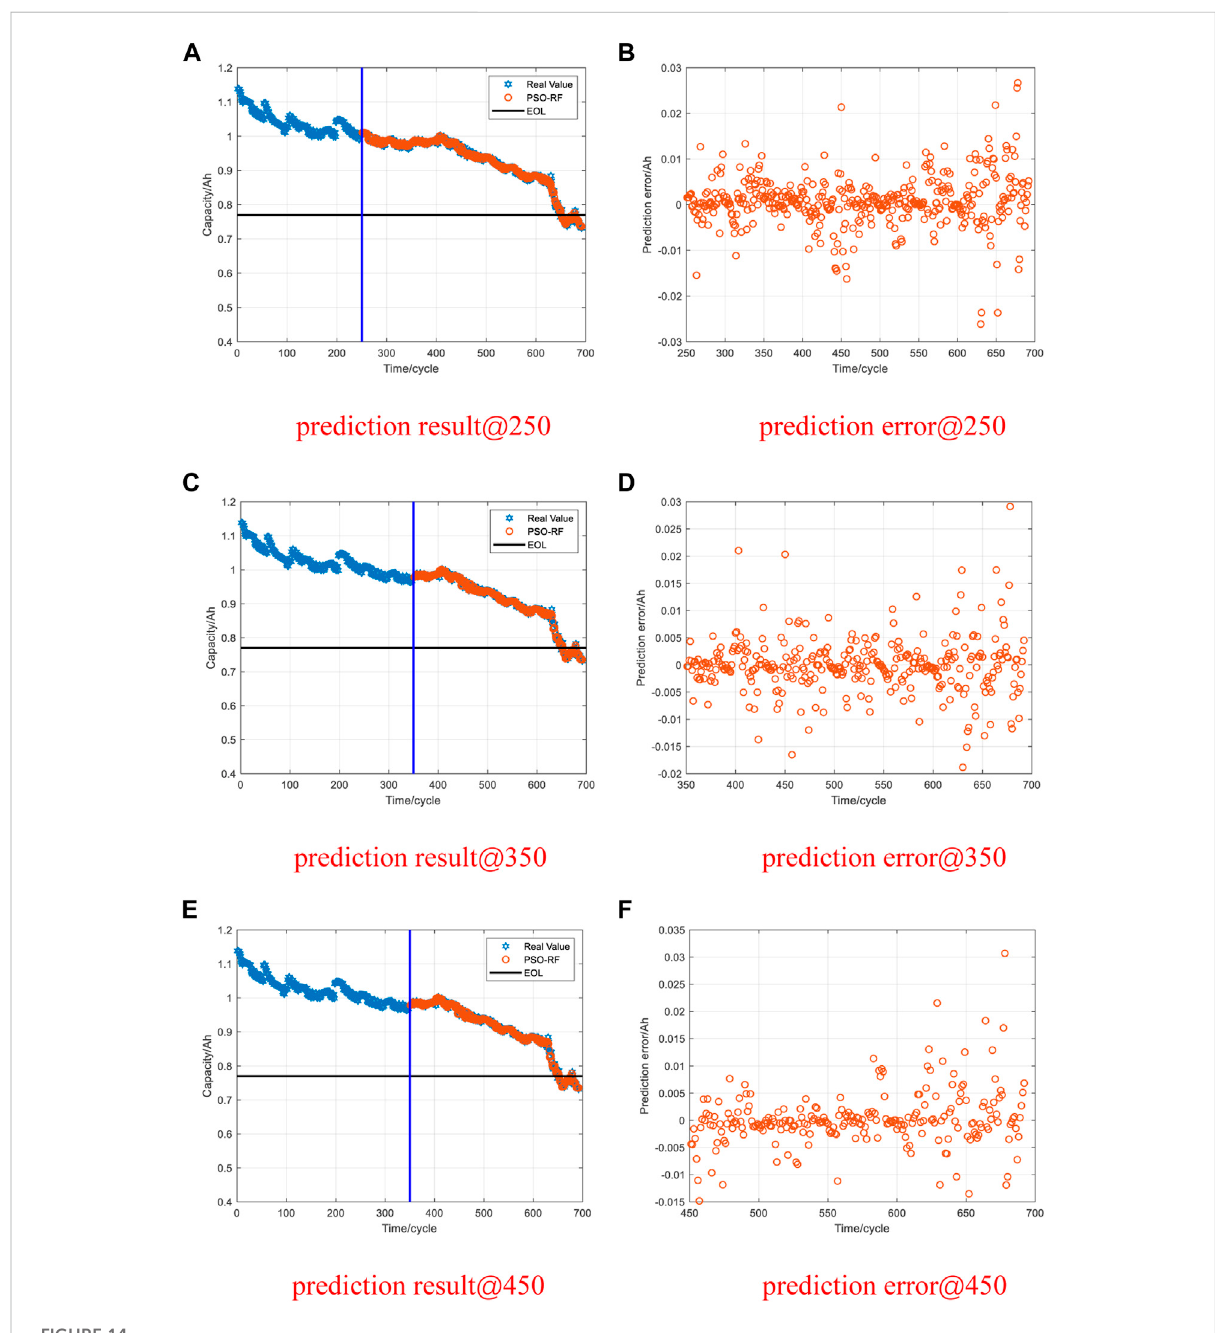
FIGURE 14 Results and errors of CS2-35